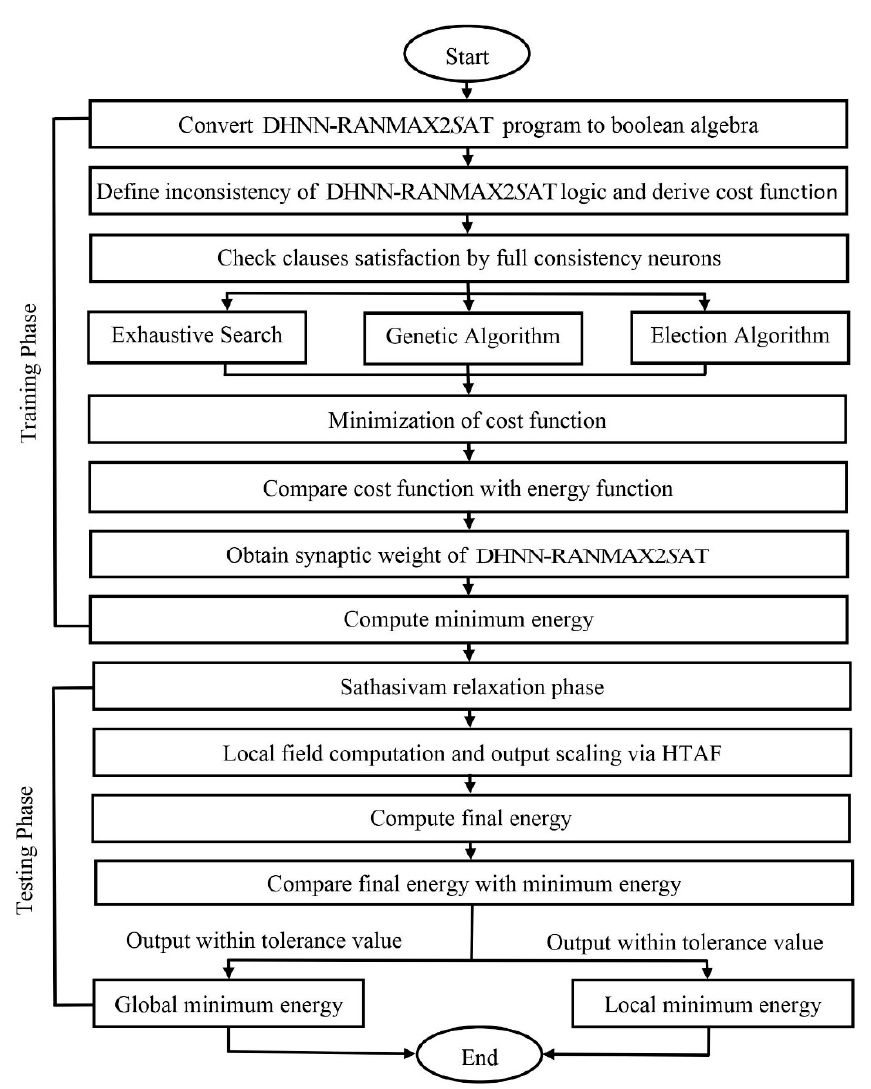
Figure 2. General flow of the proposed study.